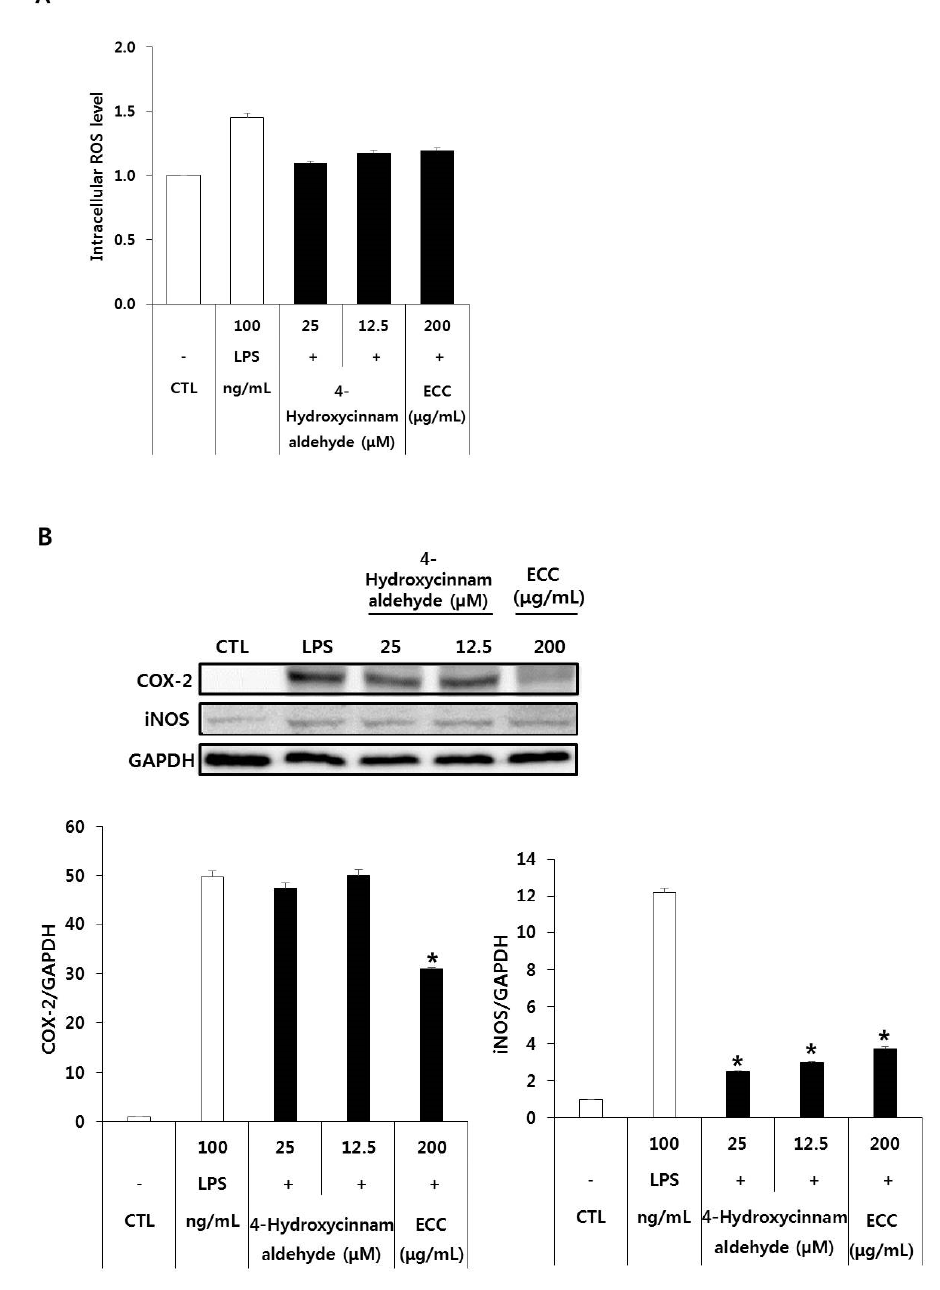
Figure 6. Expression of antioxidant properties and anti-inflammatory mediators of ECC and 4-hydroxycinnamaldehyde in LPS-induced RAW 264.7 cells. The cells were pretreated with ECC or 4-hydroxycinnamaldehyde for 2 h and then stimulated with LPS. ( A ) Intracellular ROS uptake as- sessed after incubation with 20 µ M DCFDA in the dark at 37 ◦ C for 30 min. The fluorescence intensity was measured using a microplate fluorometer. ( B ) COX-2 and iNOS expression induced by ECC and 4-hydroxycinnamaldehyde using Western blotting. The bands of the proteins were densitometrically analyzed by Image J. The data presented are the means ± SD ( n = 3). * p < 0.05 compared to the LPS group.